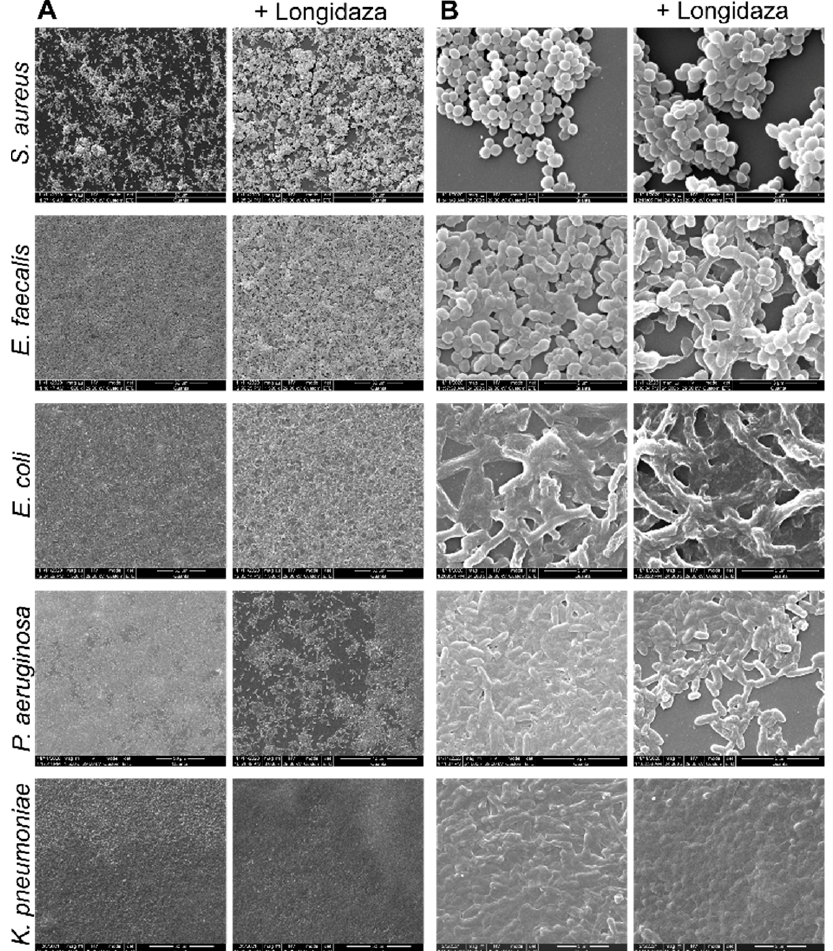
Figure 3. Scanning electron microscopy of 48-h old biofilms of S. aureus , E. faecalis, E. coli, P. aeruginosa and K. pneumoniae, treated for 24 h with Longidaza ® at concentration of 750 IU/mL. Magnification 1500 × ( A ) and 24,000 × ( B ).